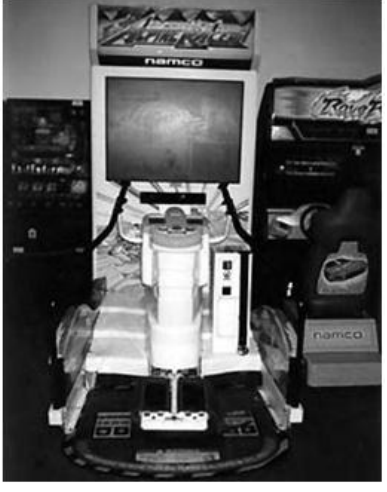
Figura 1. O jogo Alpine Racer. 2